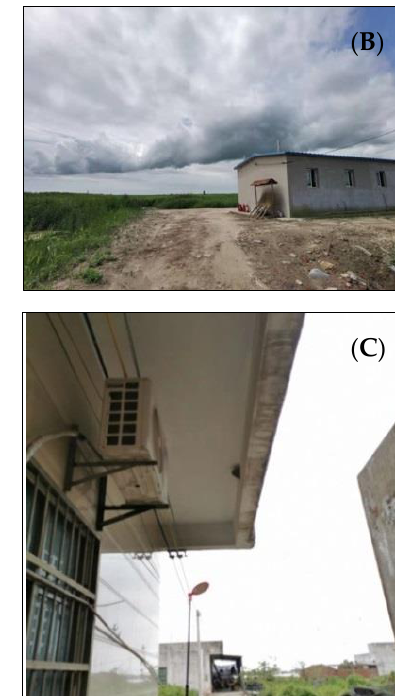
Figure 1. The locations ( A ) and habitats ( B ) Panjin, ( C ) Zhanjiang of the studied tropical and temperate barn swallow populations. Panjin (PJ) is in a temperate region and Zhanjiang (ZJ) is in a tropical region.